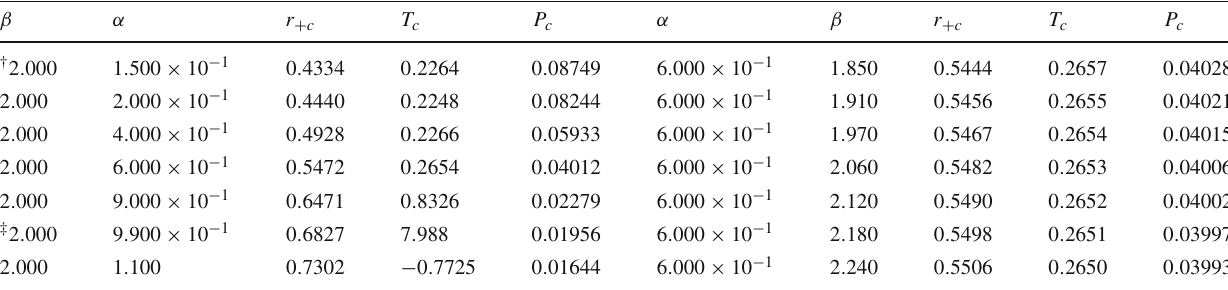
Table2 Thecriticalvaluesforzerothorderphasetransitionfor q = 0 . 2 and b = 1.Therowspecifiedwith†showstheRPTofblackholesinves- tigated in the previous section. For the row specified with ‡ , the black hole does not experience the first order phase transition and there is just